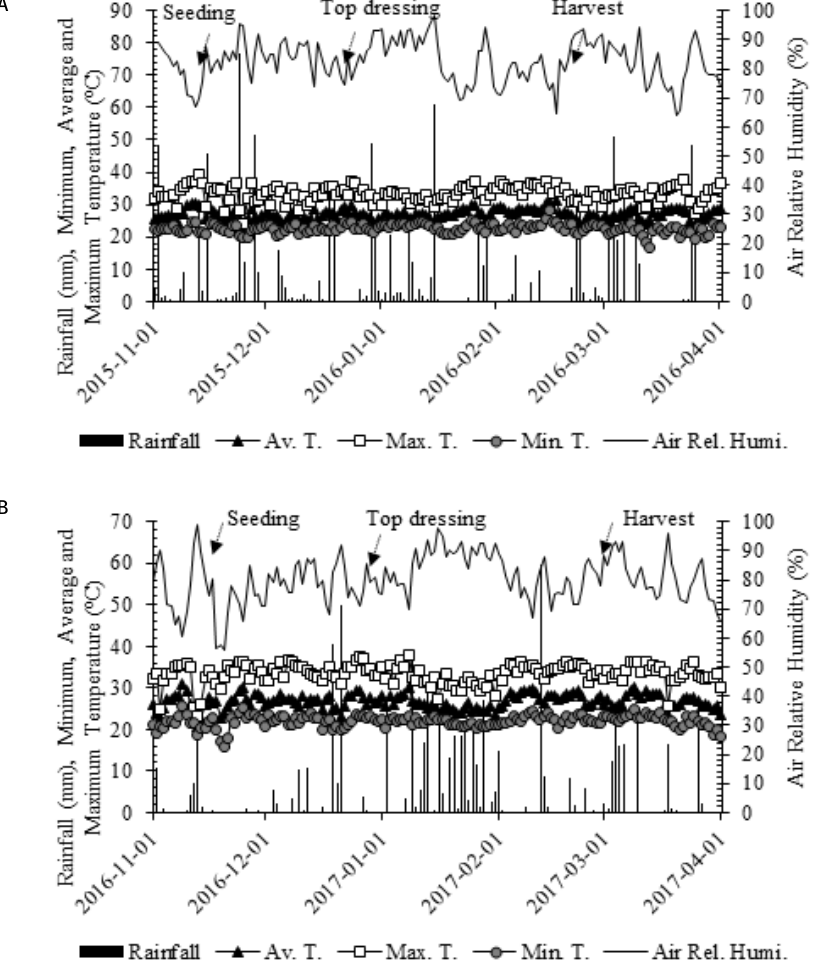
Figure 2. Rainfall, air relative humidity and maximum, average and minimum temperatures obtained from the weather station located in the Education and Research Farm of FE / UNESP during the corn cultivation in the period November 2015 to April 2016 (A) and November 2016 to April 2017